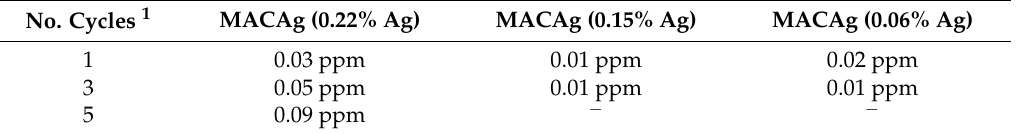
Table 1. MACAg Silver Release into 20 mL of Treated Escherichia coli ( E. coli ) Suspension in Parts Per Million. Preliminary Estimates from Atomic Absorption Spectrophotometer (Perkin–Elmer AAnalyst